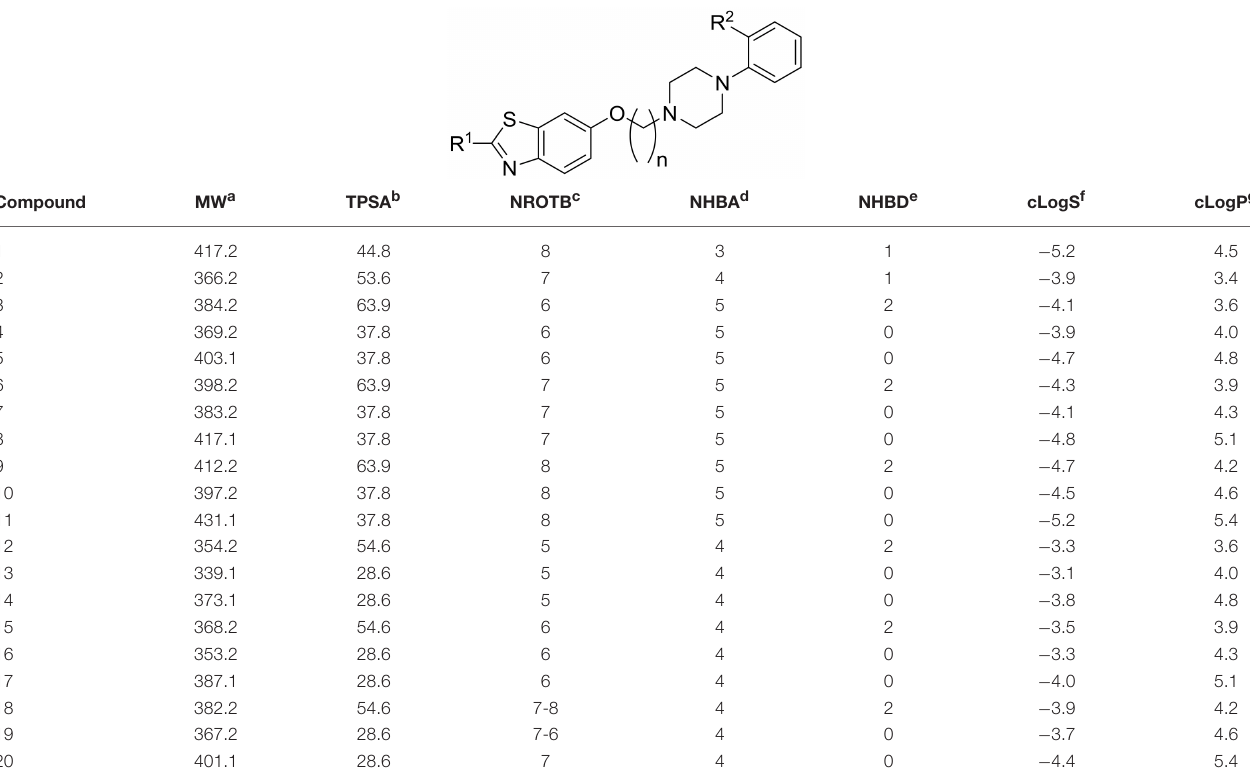
a Molecular weight. b Topological polar surface